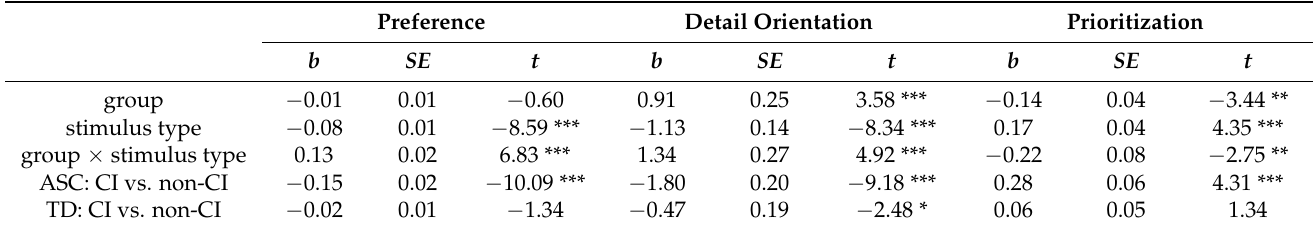
Table 2. Fixed effect estimates for three measures in Experiment